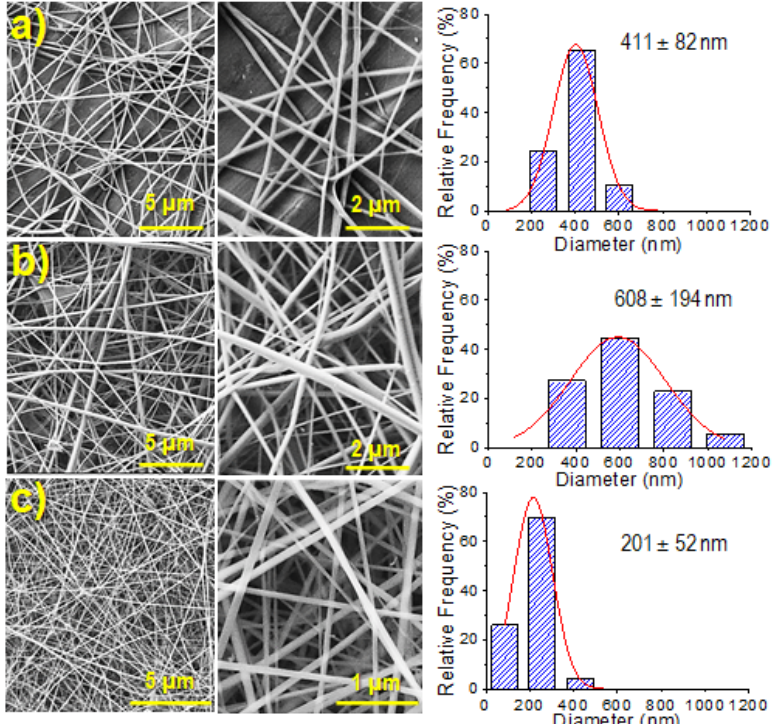
Figure 2. SEM micrographs (low and high magnification) and fiber diameter distribution of γ -PGA electrospun fibers obtained at concentrations of 5 ( a ), 8 ( b ) and 11 wt-% ( c ) using a voltage of 30 kV, a flow rate of 0.5 mL/h ( a , b ) or 0.3 mL/h ( c ) and a needle collector distance of 25 cm.